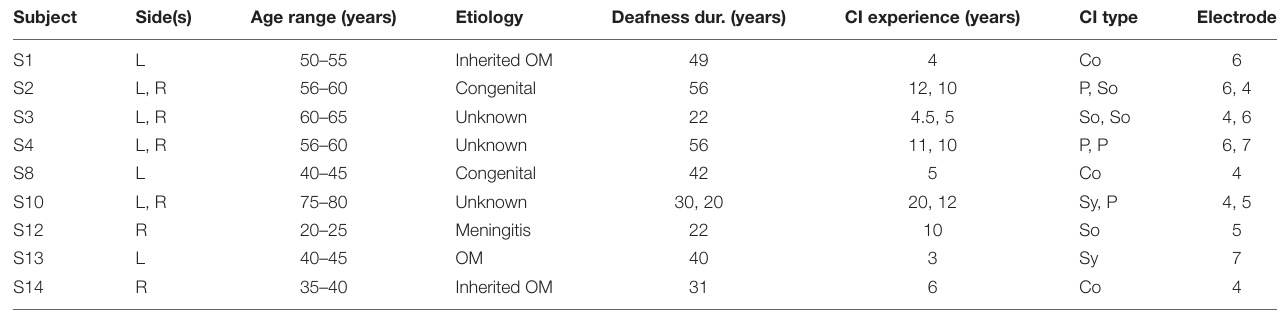
TABLE 1 | Demographic information of cochlear implant (CI) participants.